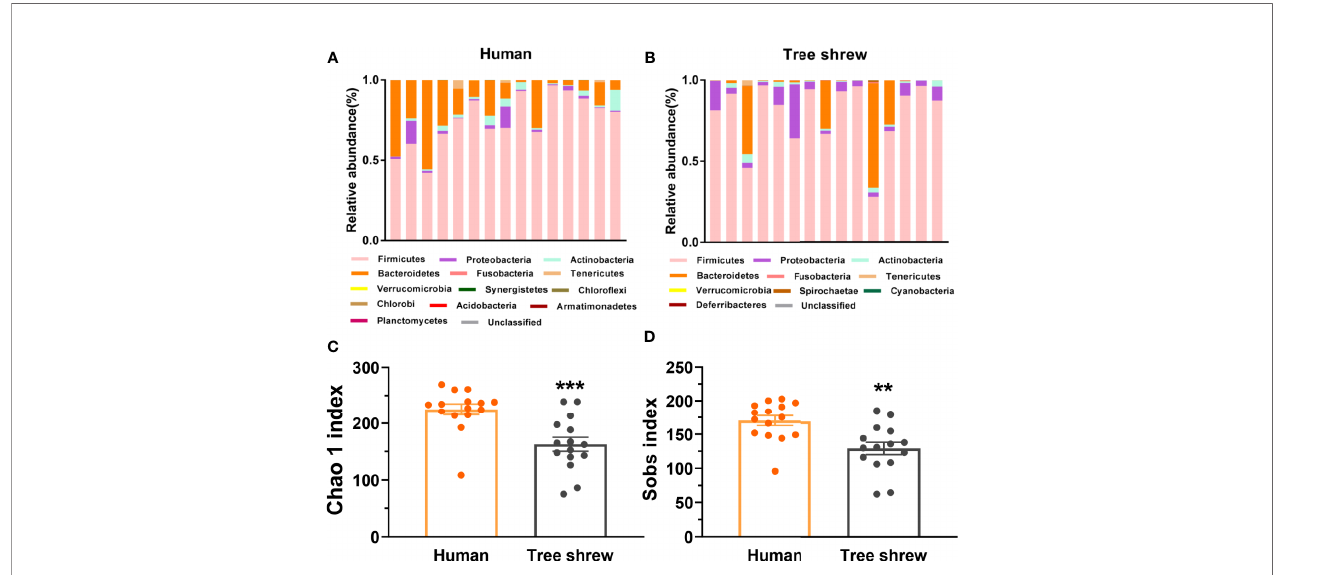
FIGURE 3 | Differential pro fi les of the gut microbiota composition and a -diversity between healthy humans and tree shrews. (A, B) The bar charts of gut microbiota abundance of healthy humans ( A , N = 15) and tree shrews ( B , N = 15). (C, D) Analysis of the a -diversity by independent t test showed that the Chao 1 index [ C , t(28) = − 3.948, p = 0.000] and Sobs index [ D , t(28) = − 3.416, p = 0.002] was lower in tree shrews than humans. Error bars show the SEM. **p <0.01, ***p